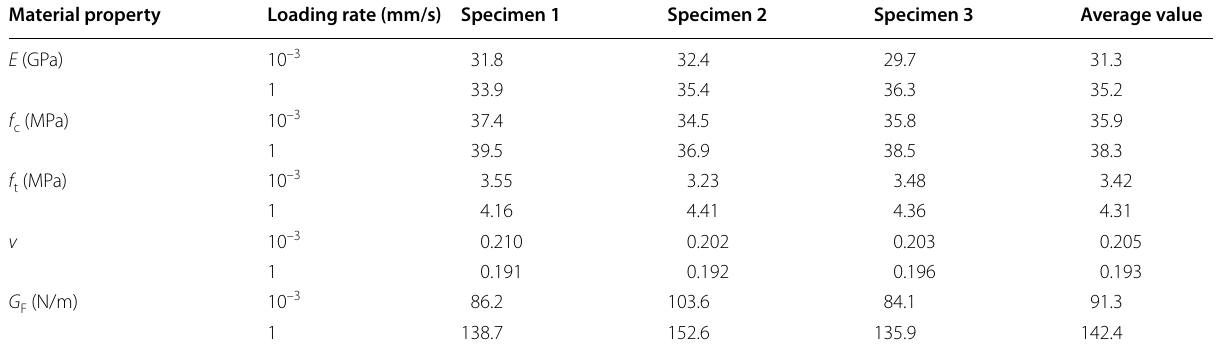
Table 2 Material properties of concrete Material property